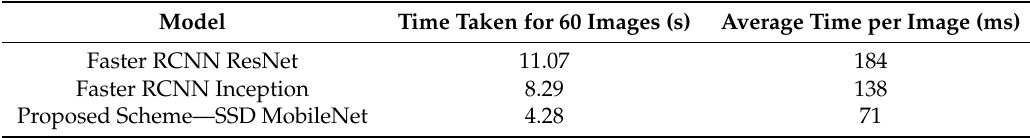
Table 4. Execution time